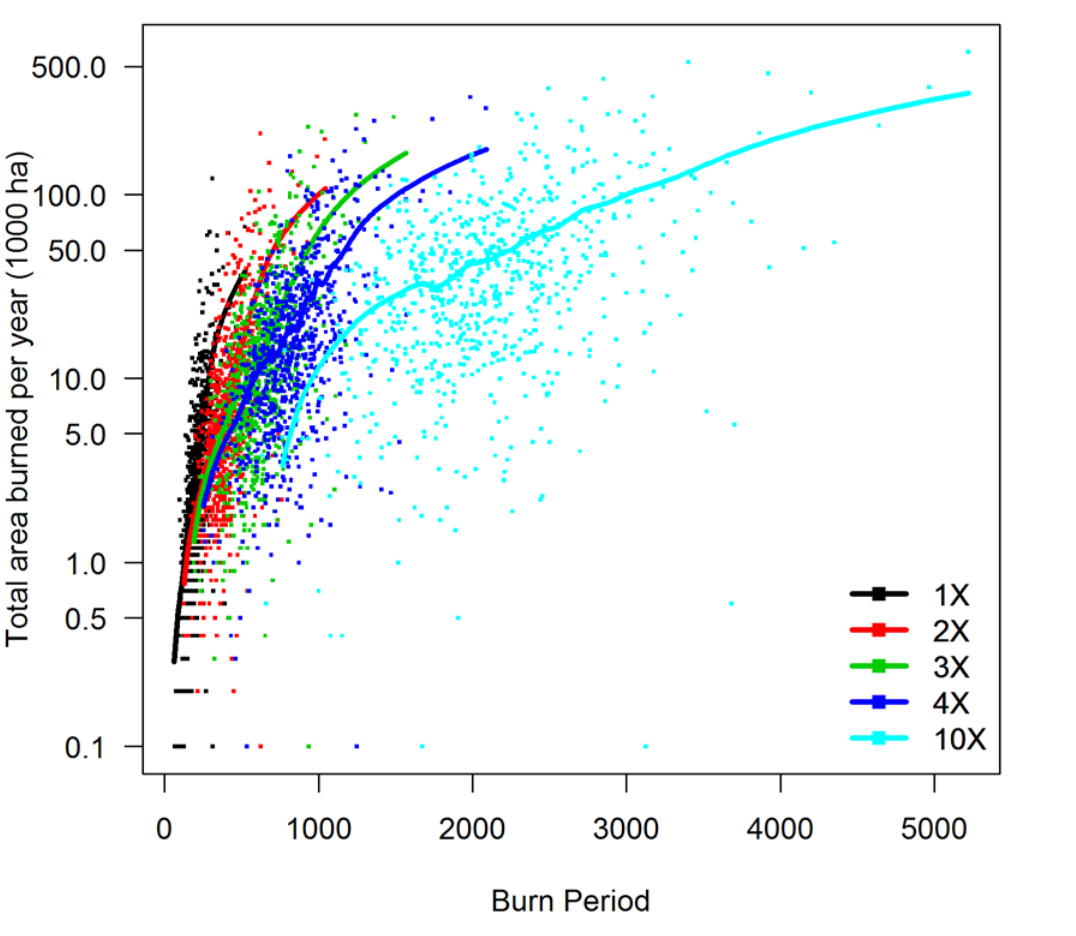
Fig. A3.2. Total area burned (1000 ha) as a function of burn period (minutes) for wildfire scenario (1X, 2X, 3X, 4X and 10X). Increased levels of wildfire activity in each scenario were achieved by multiplying the burn period of each ignition over contemporary levels by the multiplier